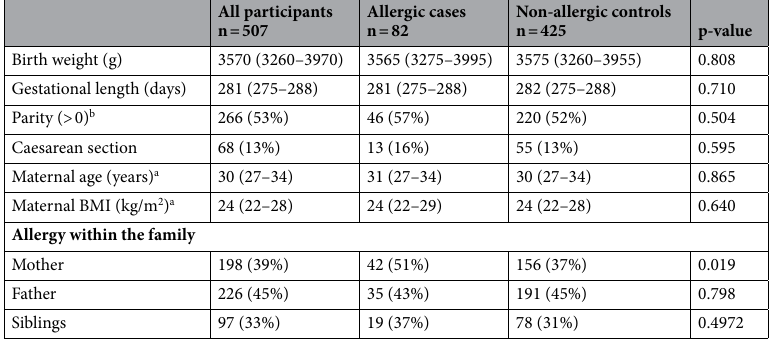
Table 1. Background characteristics for the study participants divided according to allergic diagnosis (healthy or allergic) at 12-month follow-up. a Maternal age and BMI were assessed at admission to maternity clinics in the first trimester. b Defined as either nulliparous or parous. Results presented as median (25th–75th percentile) or n (%). P values were obtained with Mann–Whitney tests for continuous data and with Pearson’s chi-squared test for categorical